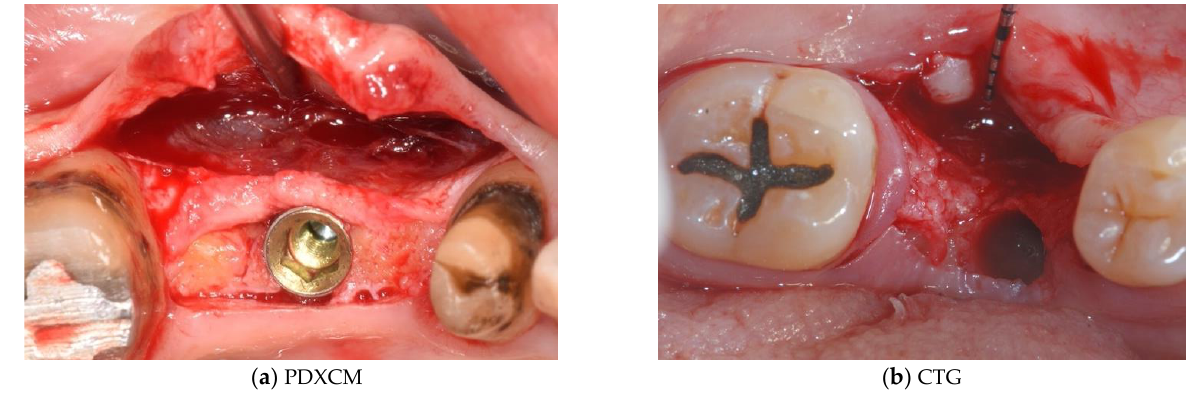
Figure 2. ( a , b ) with a bilaminar technique a split thickness flap allows us to keep periosteum and muscular insertion in order to maintain periosteal vascularization of the bone and to have soft tissue available to suture the matrix or CTG.